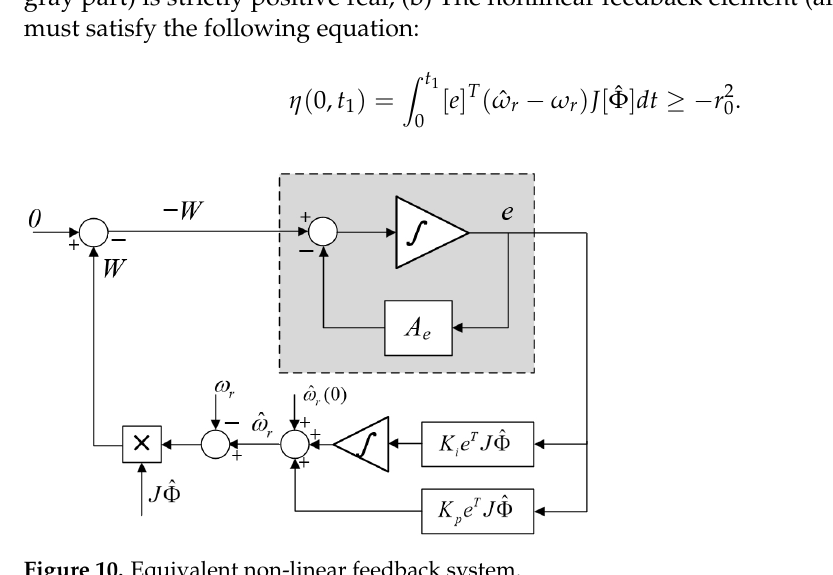
Figure 10. Equivalent non-linear feedback system.